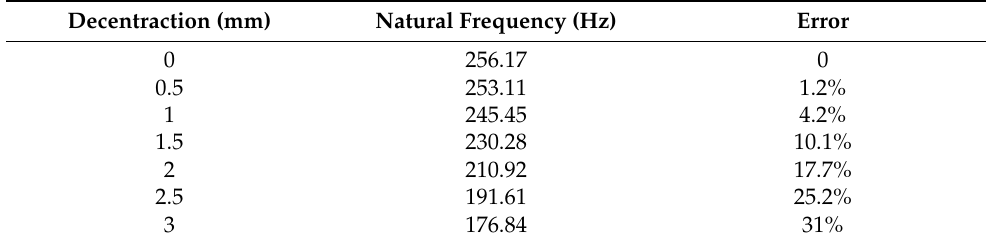
Table 3. The 3rd order natural frequency error under different parallel non-concentricity of the 3rd order. Decentraction (mm) Natural Frequency (Hz) Error 0 256.17